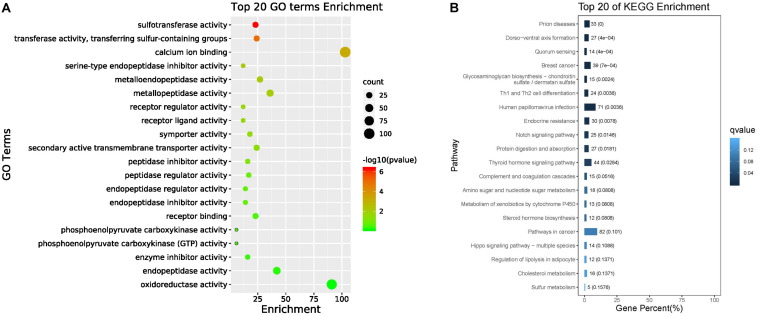
Top 20 enriched GO terms (A) and top 20 enriched KEGG pathways (B).